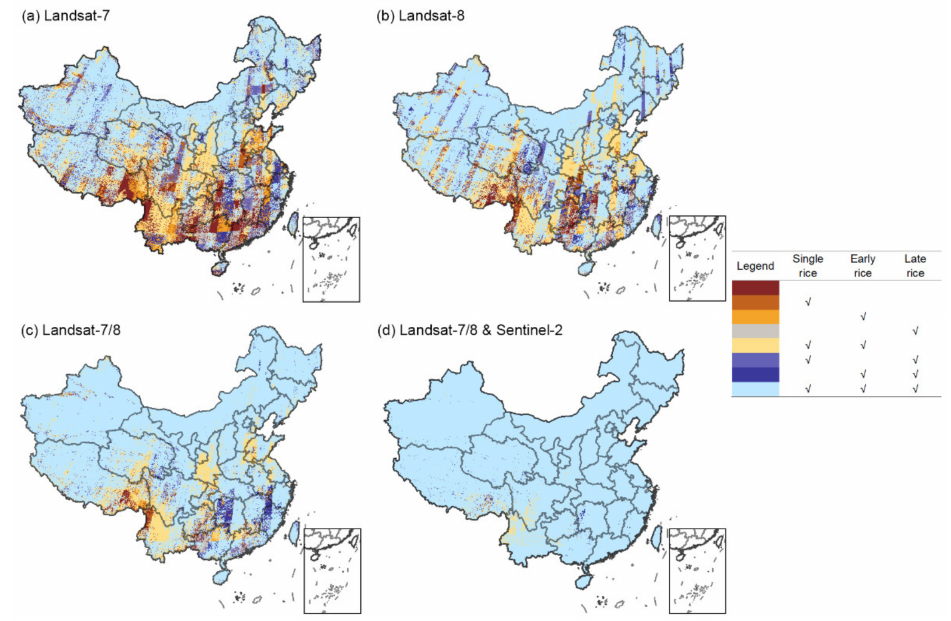
Figure 7. Spatial patterns of rice types identifiable by different sensors and combinations in